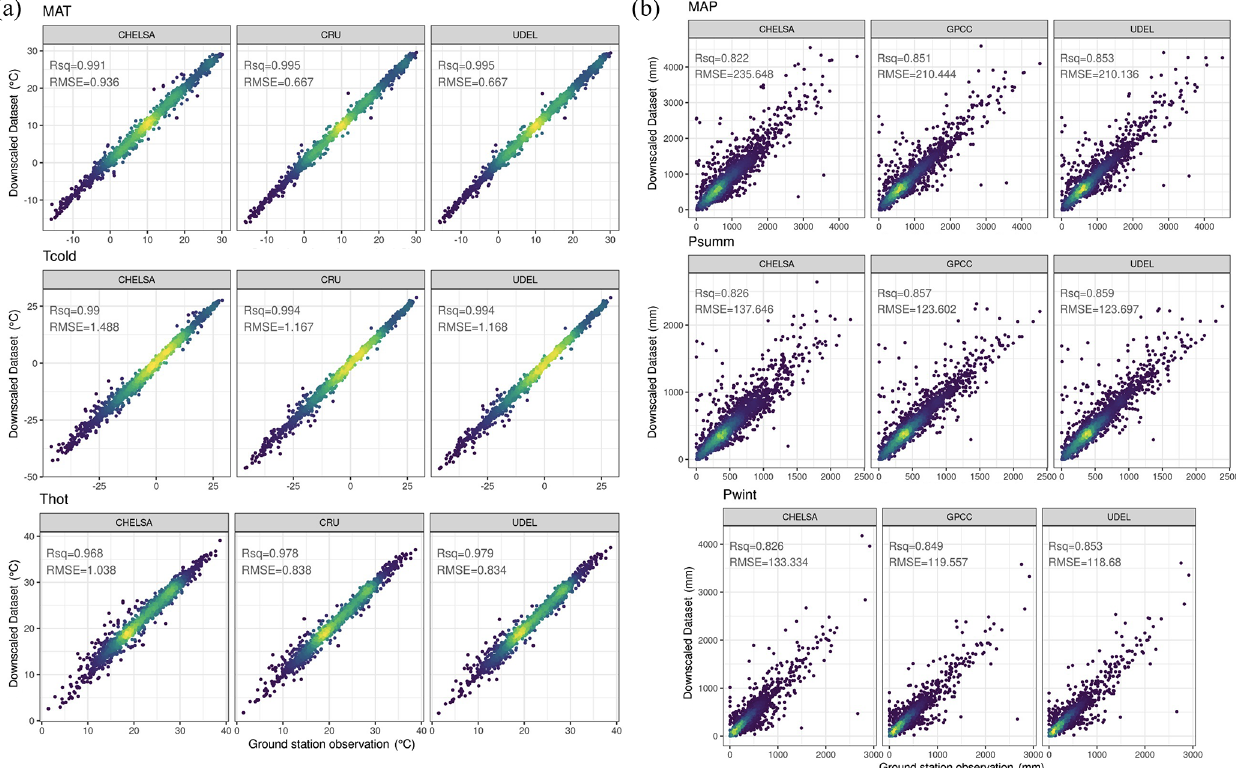
Figure 9. Scatter plots of the station observations and estimates of bioclimatic variables from downscaled climatology data. The bioclimatic variables include the 30-year means of annual temperature (MAT), the air temperature of the coldest month ( T cold ), the air temperature of the warmest month ( T hot ), total annual precipitation (MAP), precipitation of the summer half year ( P summ ), and precipitation of the winter half year ( P wint ). (a) Scatter plots of the station observations and downscaled temperature data from CHELSA, CRU, and UDEL datasets and (b) downscaled precipitation data from CHELSA, GPCC, and UDEL